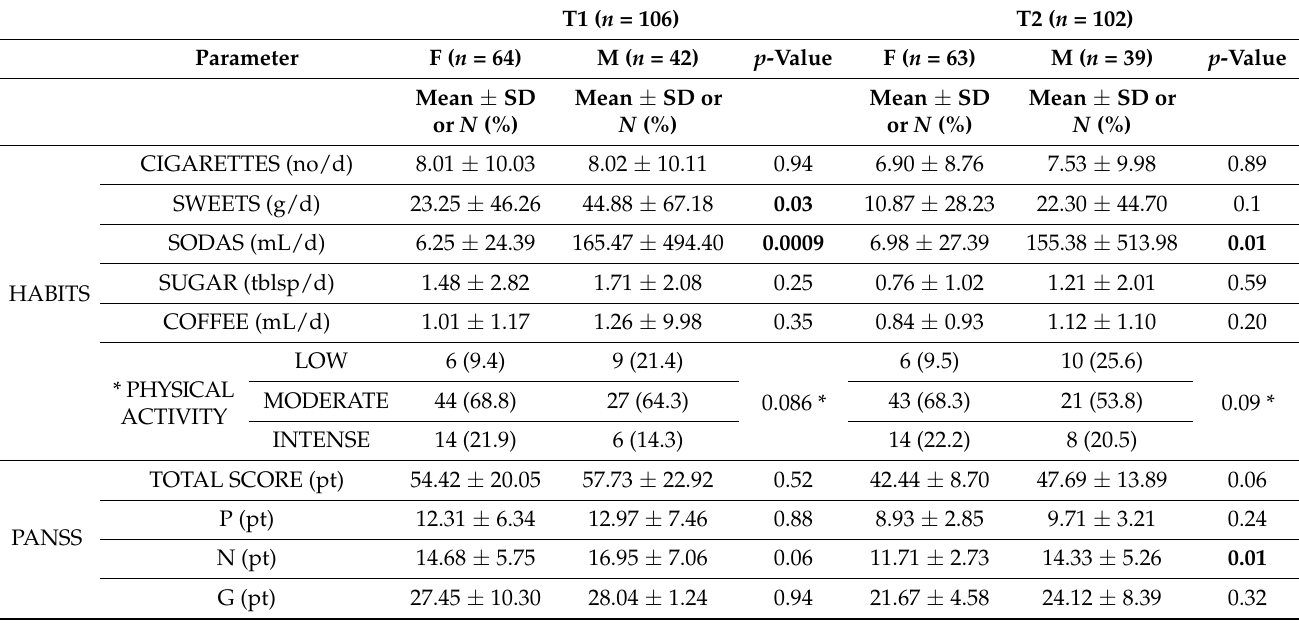
Table 4. Gender-specific comparison of selected lifestyle choices and PANSS scores at T1 and